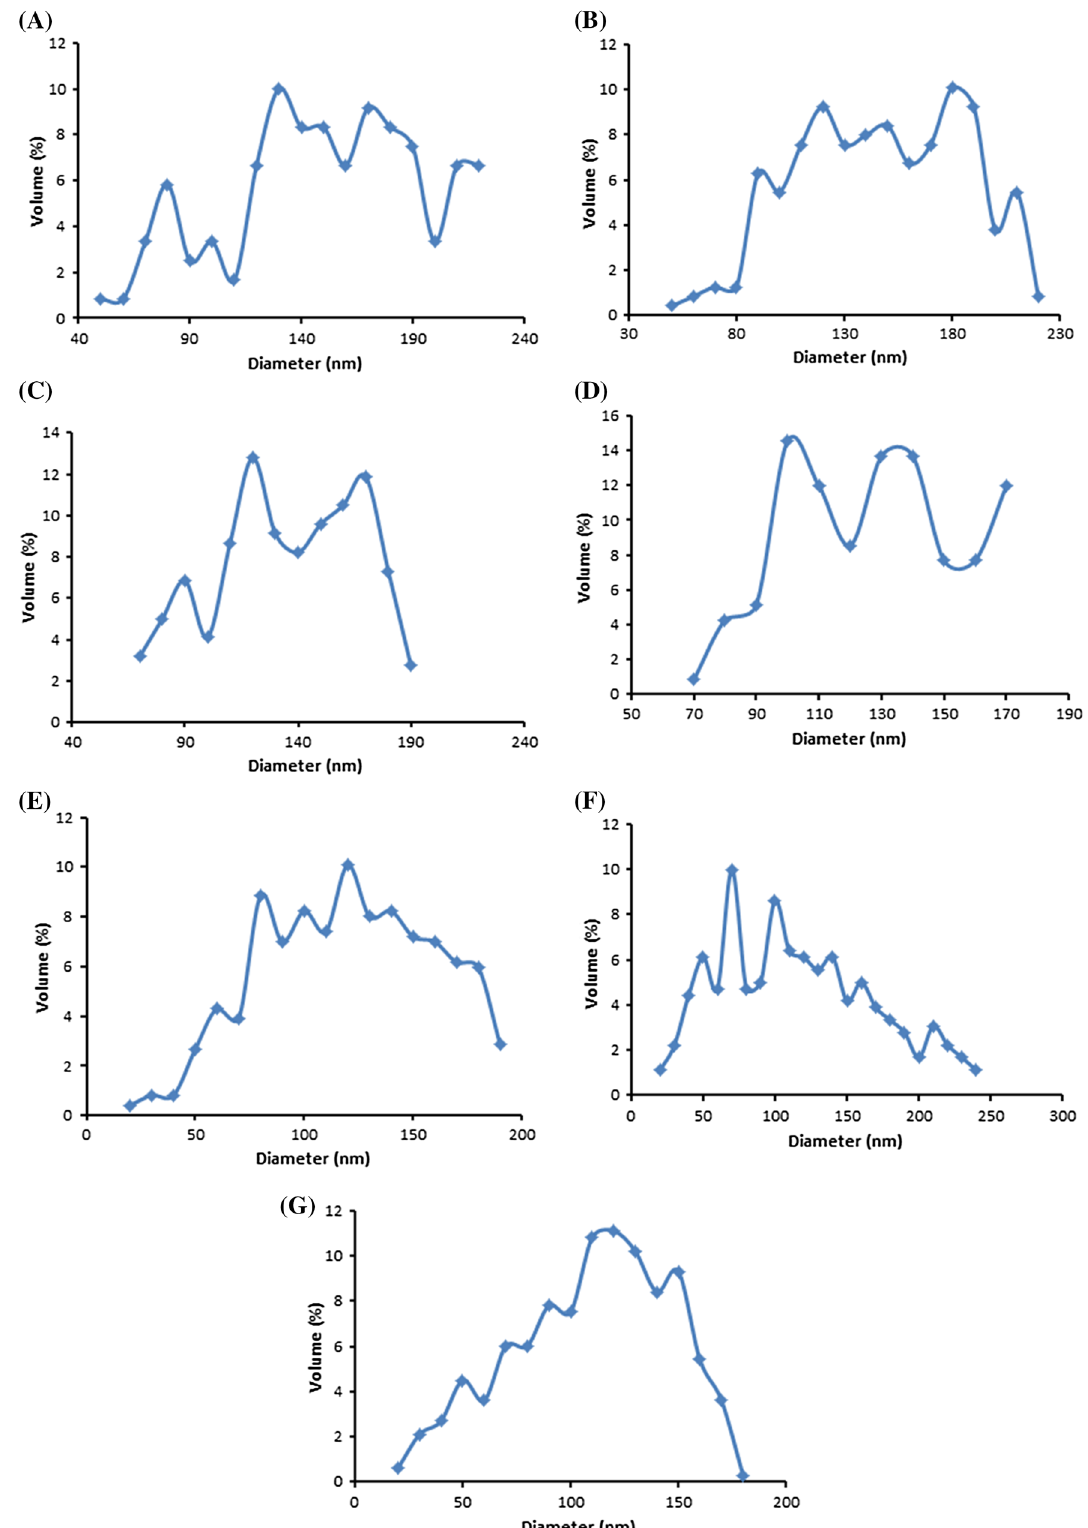
Fig. 9 Pore size distribution of the inner